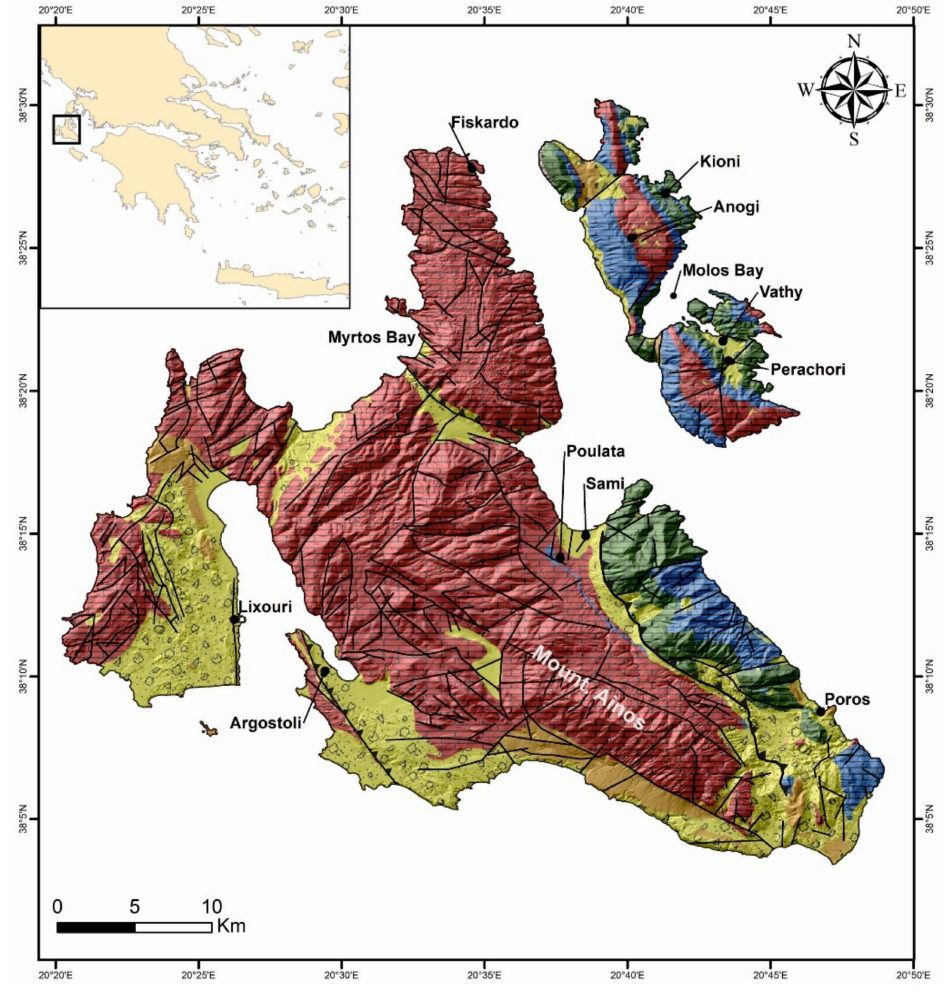
Figure 3. Geological map of Kefalonia and Ithaki island, showing the distribution of the geotectonic units and the main faults and thrusts. For the legend of the geological formations see Figure